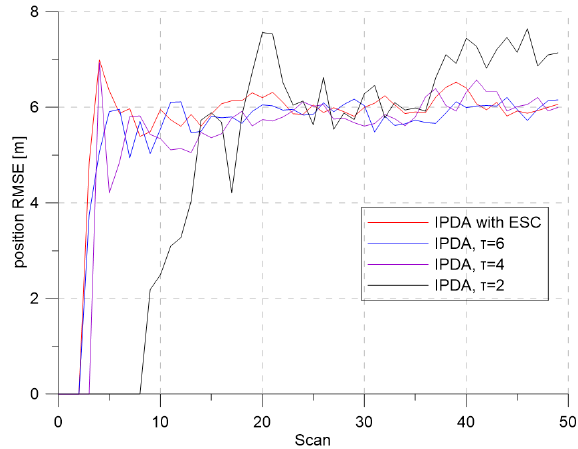
Figure 10. Range RMSE for λ = 0.8.